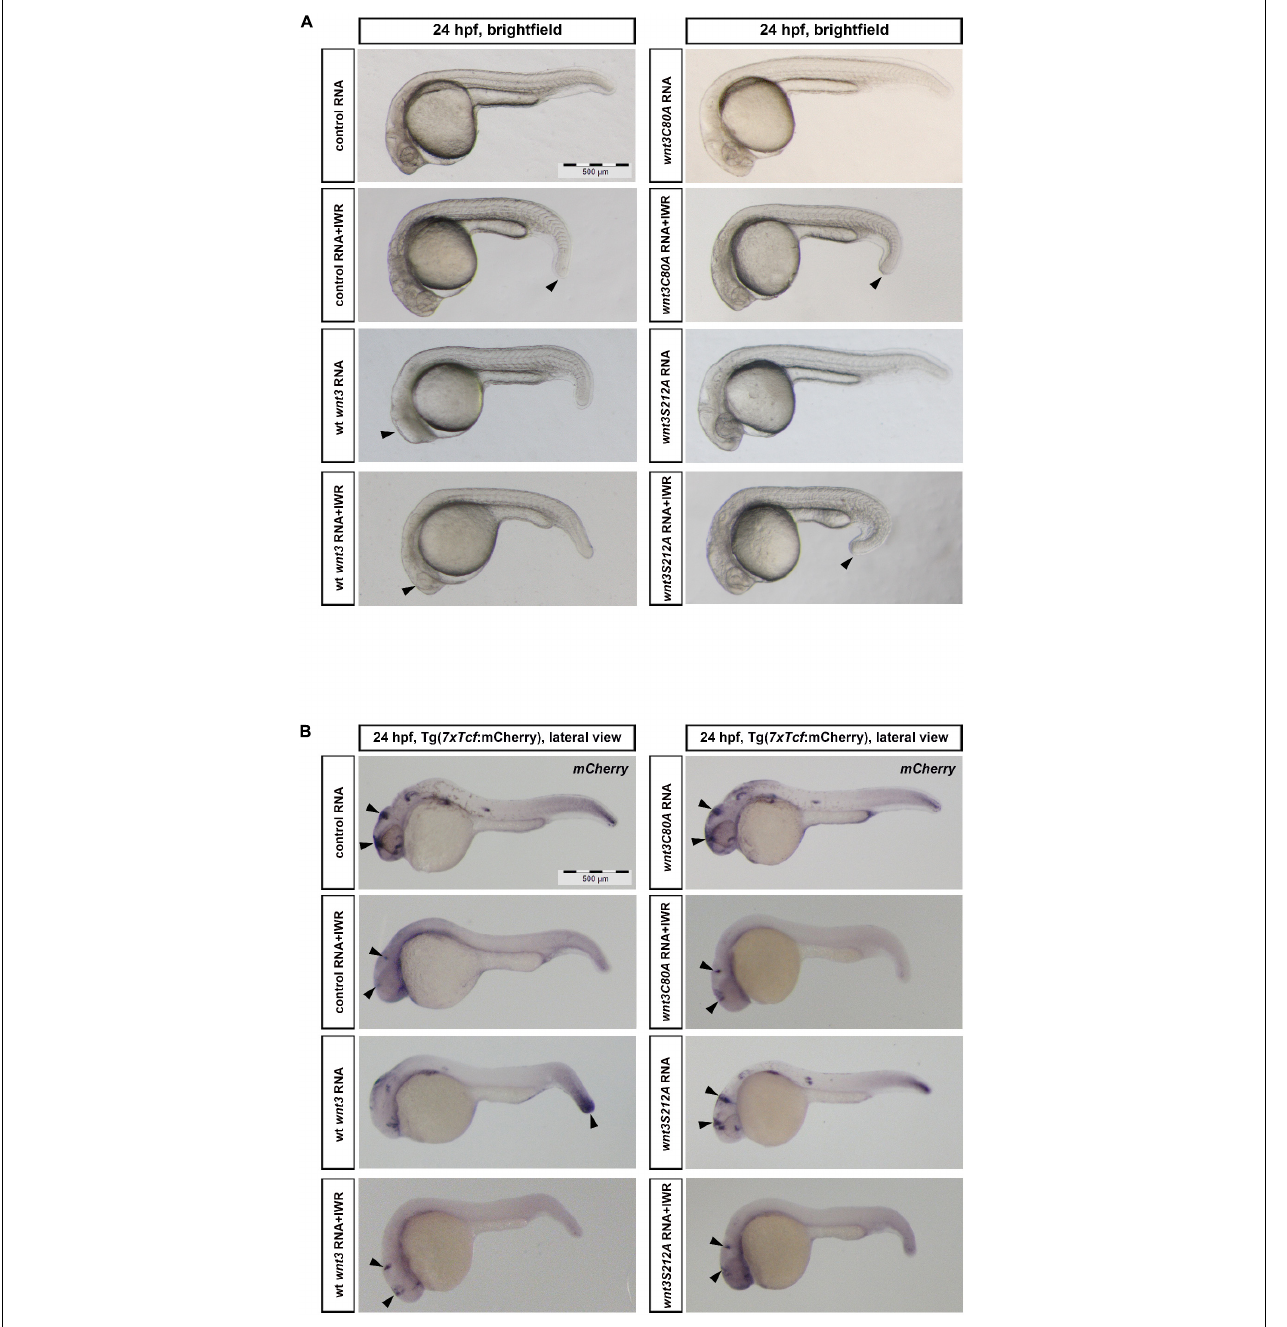
FIGURE 9 | Influence of C80 and S212 residues on Wnt signaling activity (A) Morphological phenotypes at 24 hpf of embryos injected/treated with capped sense RNAs of control (EGFP 100 pg, 37/37 embryos), control +IWR (42/42 embryos, arrowhead: reduction in tail elongation), wt Wnt3 (100 pg, 47/53 embryos, arrowhead: loss of eye), Wnt3-EGFP + IWR (36/43 embryos, arrowhead: restoration of eye), Wnt3C80A-EGFP (100 pg, 41/43 embryos), Wnt3C80A-EGFP + IWR (41/44 embryos, arrowhead: reduction in tail elongation), Wnt3S212A-EGFP (100 pg, 52/54 embryos) or Wnt3S121A-EGFP + IWR (43/46 embryos, arrowhead: reduction in tail elongation). IWR was used at a concentration of 10 µ M and DMSO was used in groups that were not treated with IWR. (B) Whole mount in situ hybridization (WMISH) in the transgenic Tg( 7xTcf-Xla.Siam:nlsm-Cherry ia ) canonical Wnt/ß-catenin reporter embryos showing the effects of control (EGFP 100 pg, 33/33 embryos, arrowheads: anterior Wnt expression domains), control + IWR (45/45 embryos, arrowheads: reduction in anterior Wnt expression domains), Wnt3-EGFP (100 pg, 41/49 embryos, arrowheads: increase in posterior Wnt expression domain), Wnt3-EGFP + IWR (40/45 embryos, arrowheads: restoration of anterior Wnt expression domain), Wnt3C80A-EGFP (100 pg, 45/48 embryos, arrowheads: no effect on anterior Wnt expression domains), Wnt3C80A-EGFP + IWR (38/39 embryos, arrowheads: reduction in anterior Wnt expression domains), Wnt3S212A-EGFP (100 pg, 44/46 embryos, arrowheads: no effect on anterior Wnt expression domains) or Wnt3S121A-EGFP + IWR (50/53 embryos, arrowheads: reduction in anterior Wnt expression domains) on canonical Wnt signaling. IWR was used at a concentration of 10 µ M and DMSO was used in groups that were not treated with IWR1. mCherry WMISH shows upregulation of signaling in Wnt/ß-catenin reporter embryos by Wnt3-EGFP but not by Wnt3C80A-EGFP or Wnt3S212A-EGFP.